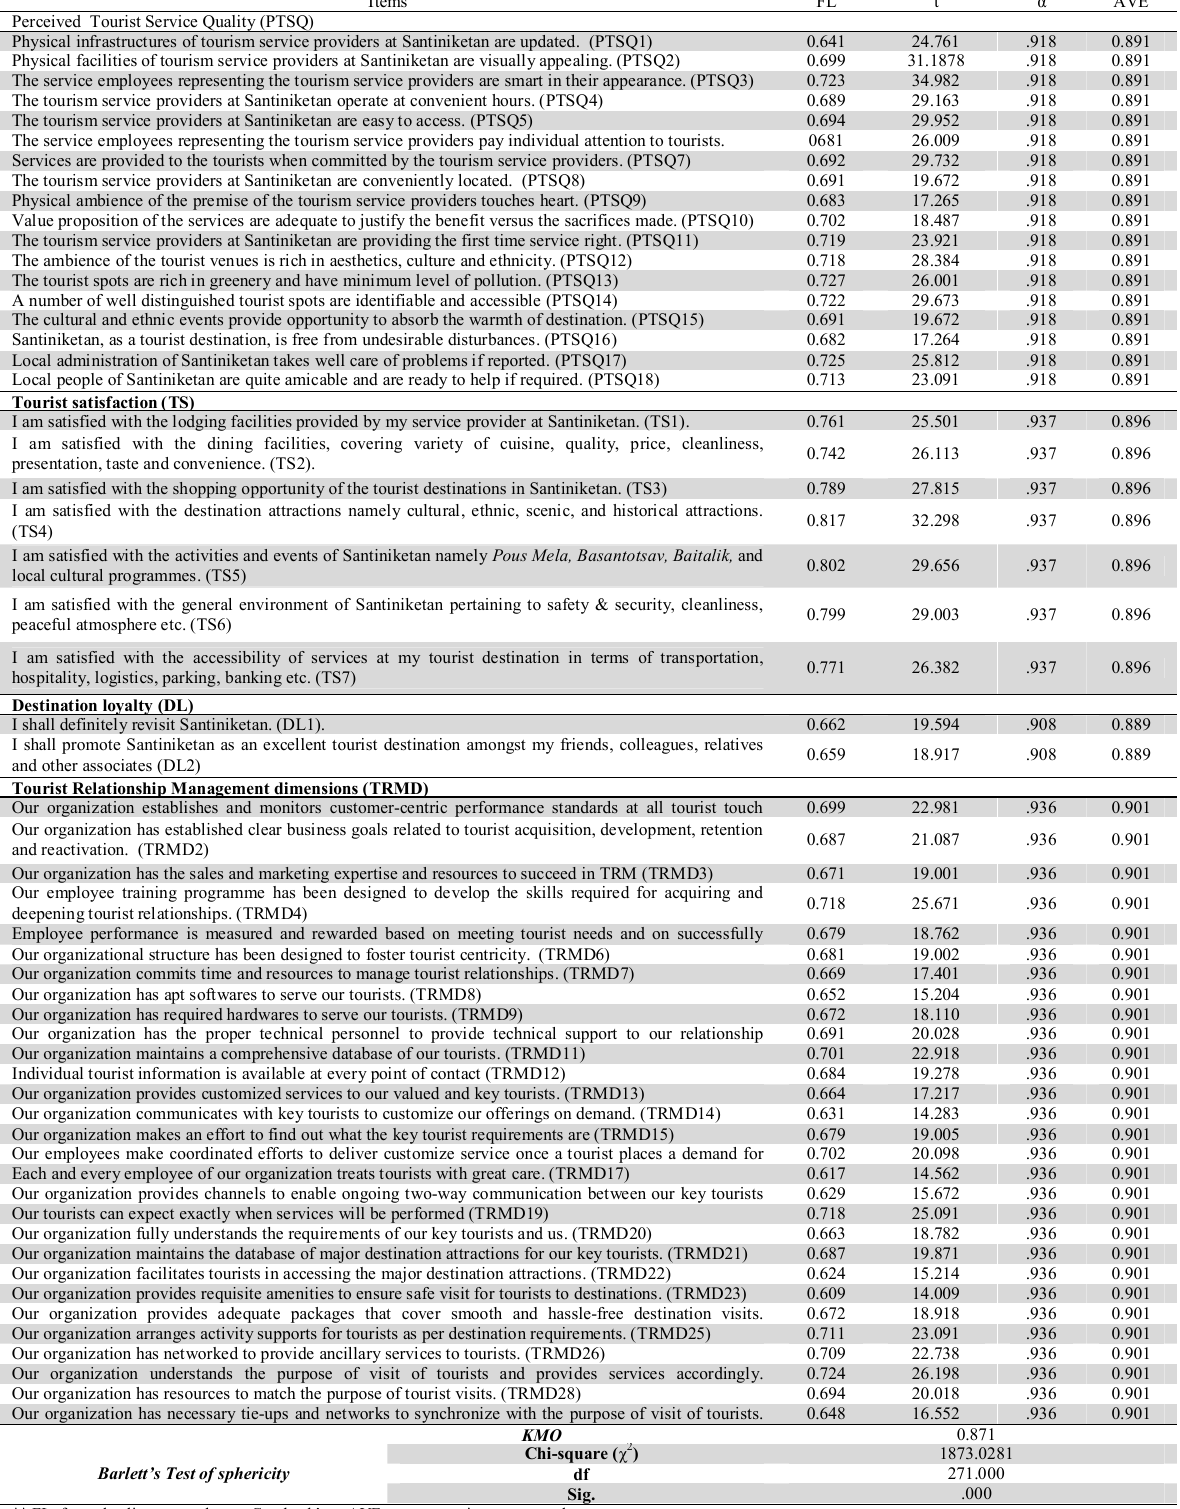
Measurement of reliability and validity of the